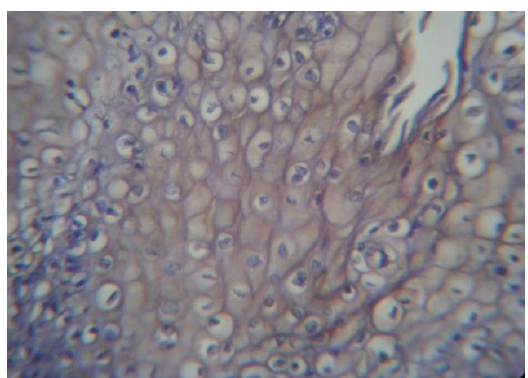
Figure (3): Membranous and cytoplasmic NRP1 expression in Skin SCC